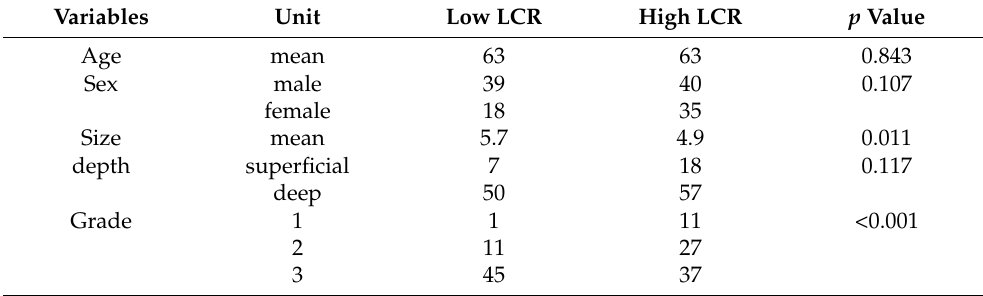
Table 2. Relationship between lymphocyte-to-C-reactive protein ratio and clinical